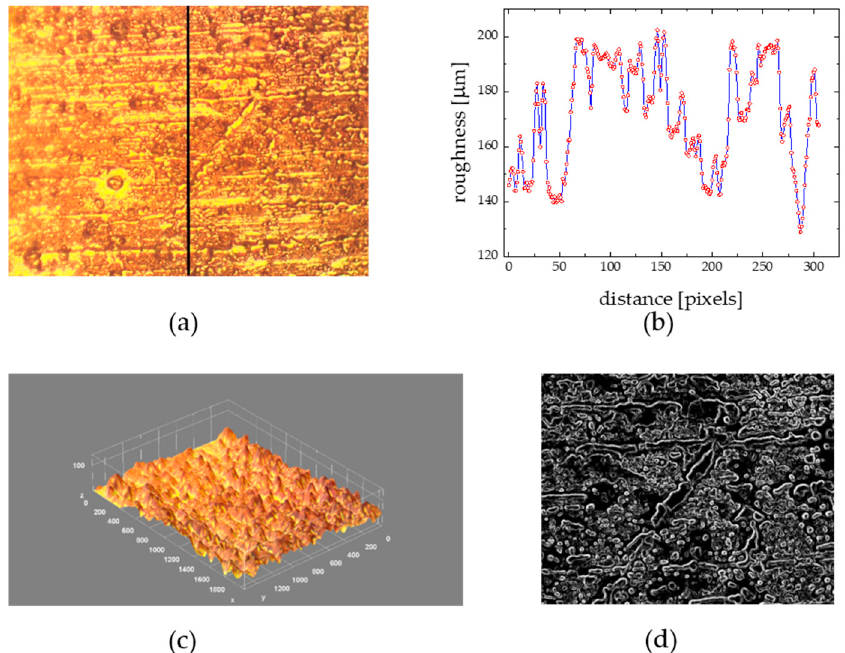
Figure 7. ( a ): A microscopic image of Al roughened surface covered with a marine biofilm (14-day old), collected in Baltic sea water (Gulf of Gda´nsk, Poland; August, 2018); ( b ): roughness height profile along the line from ( a ), ( c ): 3D surface morphology from ( a ) derived with ImageJ routine, ( d ): ( a ) processed with ”find edges” procedure; covered area x = 670 and y = 530 µ m. Distance scale 180 pixels = 50 µ m; morphology parameters: surface coverage f = 64.6%, mean thickness = 16 µ m, biovolume = 34,500 µ m 3 , roughness fluctuation coefficient η = 0.132, fractal dimension = 1.26, Hopkin’s aggregation index = 2.34, AC =